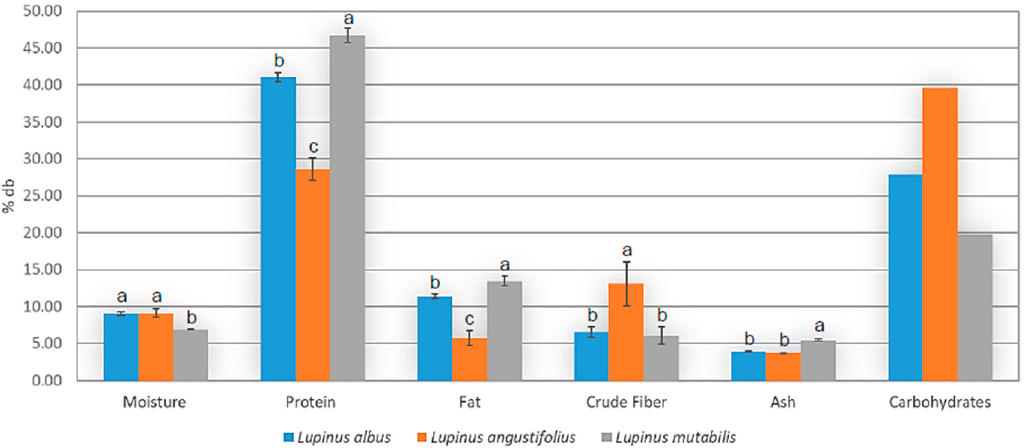
Figure 4. Proximate analysis (% db: dry basis percentage) of lupin flours of different varieties. Bars with different letters within proximate parameters are statistically different ( p < 0.05).